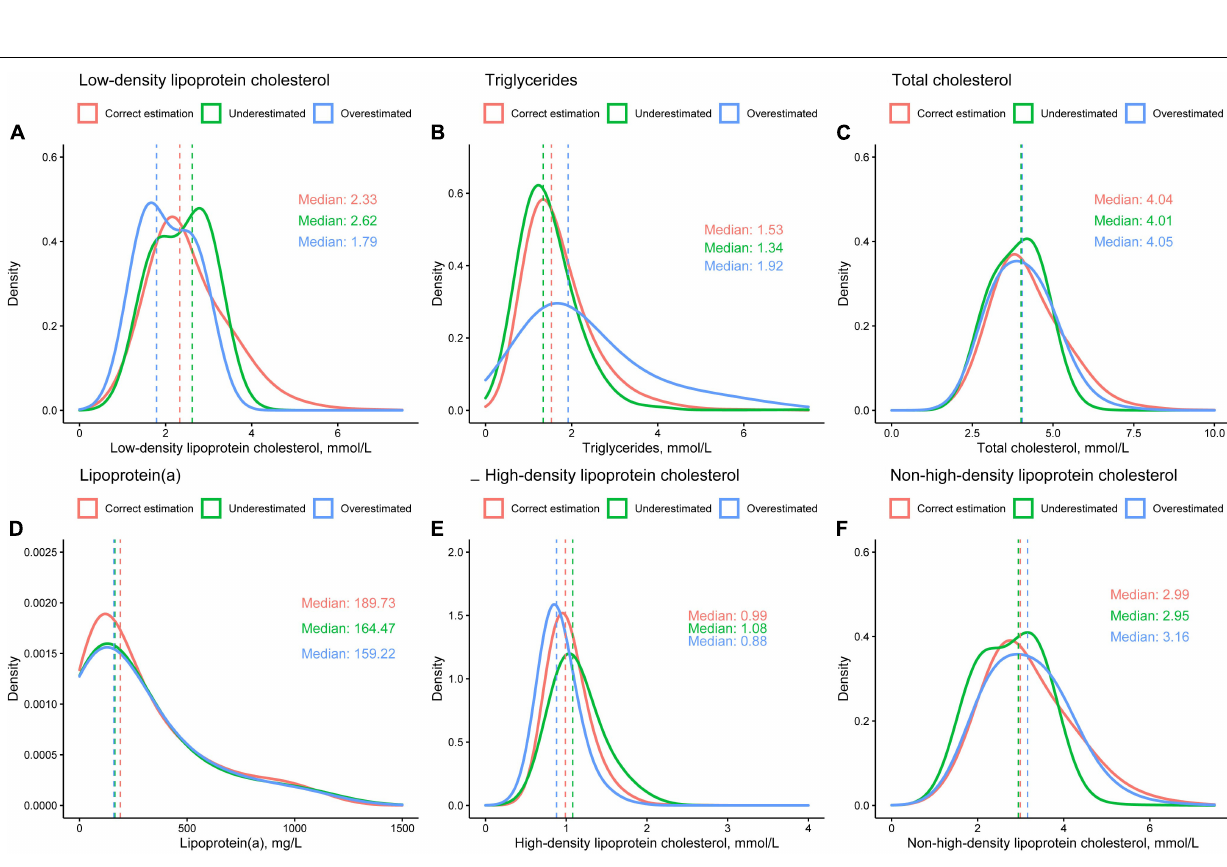
Frontiers in Cardiovascular Medicine |